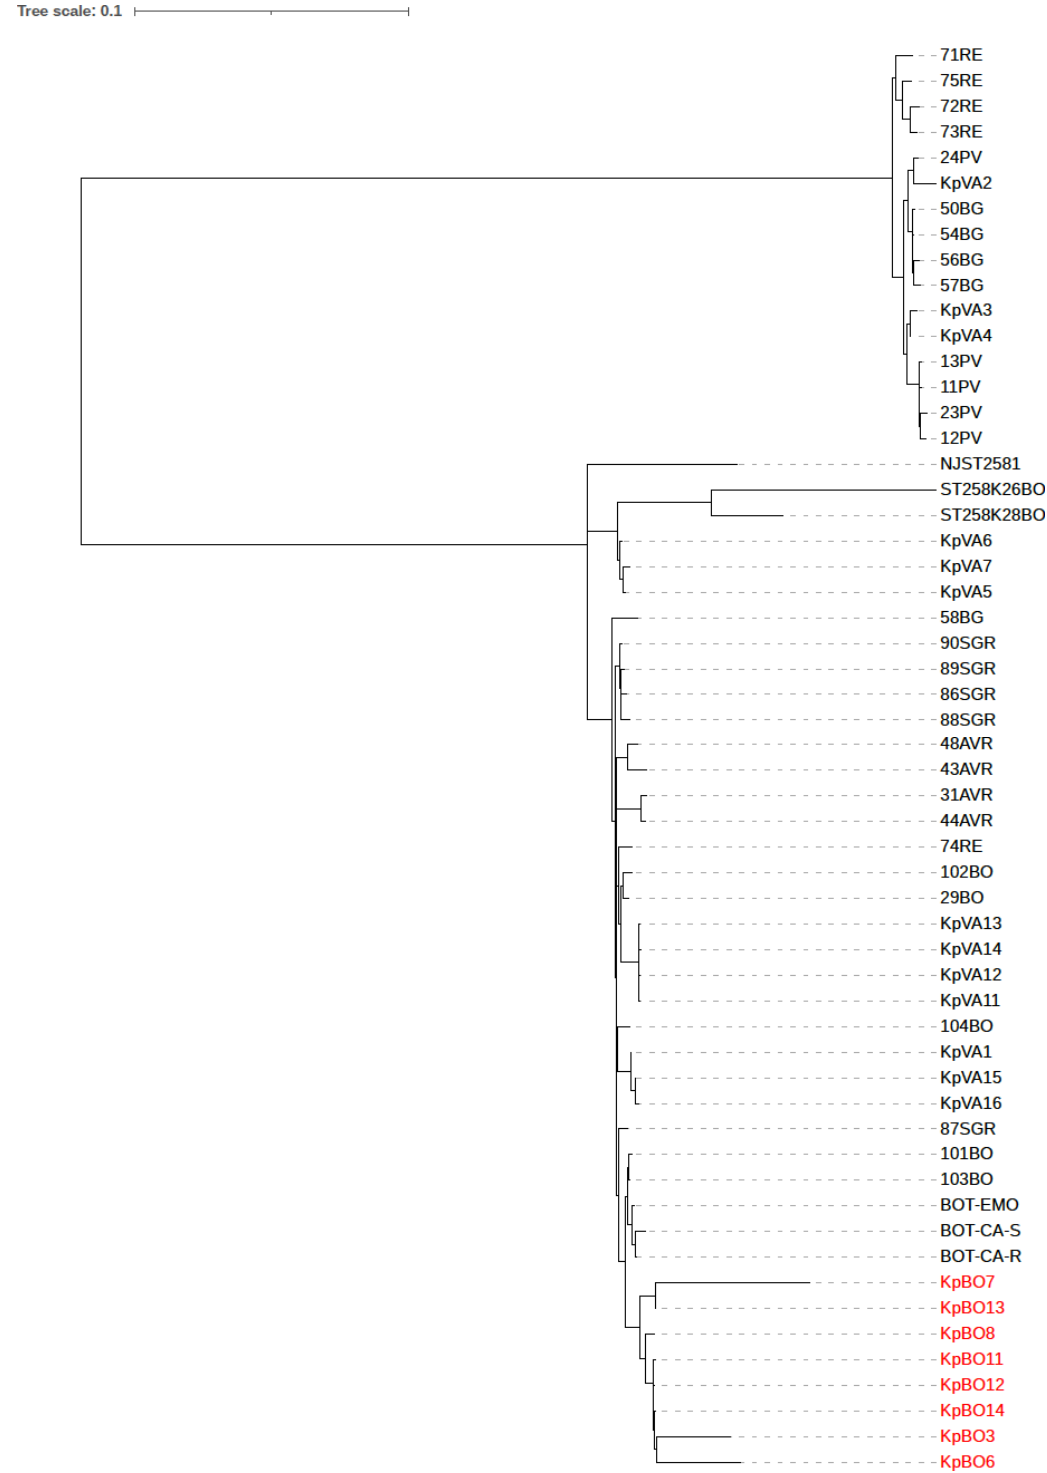
Figure 1. Phylogenetic tree based based on the core genome SNP of KPC-producing K. pneumoniae (KPC-Kp) isolated in Italy and strains included in this study. The KPC-Kp clinical isolates included in this study are highlighted in red. The genome of strain NJST2581 was used as a reference genome.